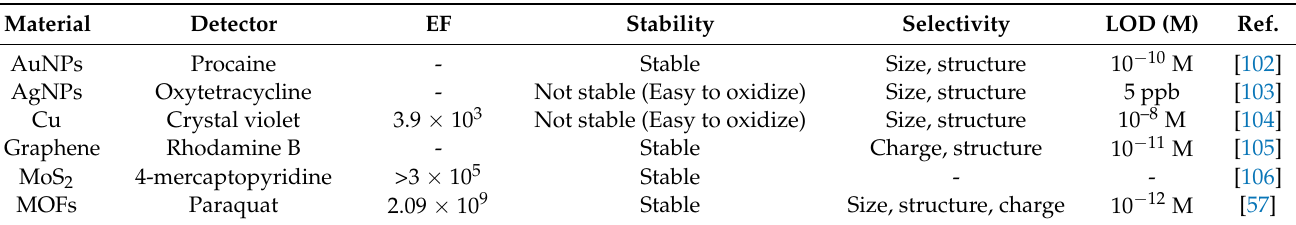
Table 2. Comparison between MOFS and other SERS